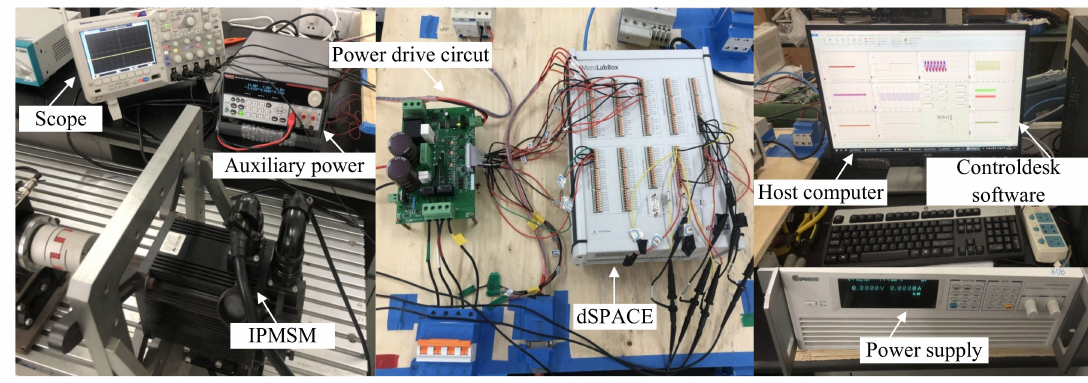
Figure 11. The experimental platform based on dSPACE.